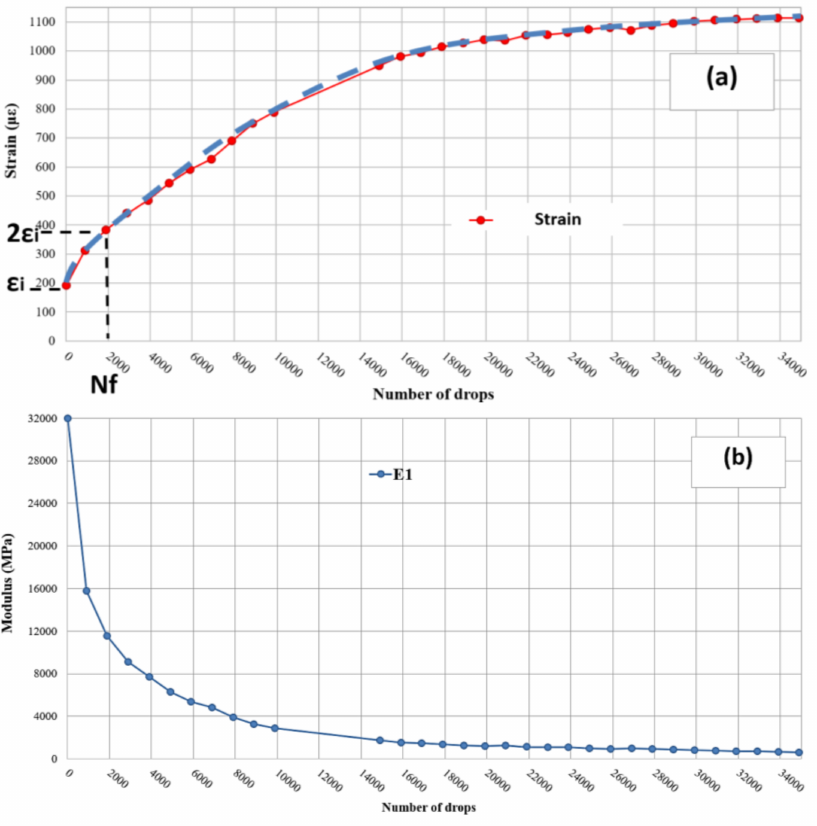
Figure 8. Example of backcalculated ( a ) strains and ( b ) moduli for the test point 5 (tested at 1050 kPa). To compute the initial deflection, data related to the first 100 drops has been discarded, in compliance with the UNI EN